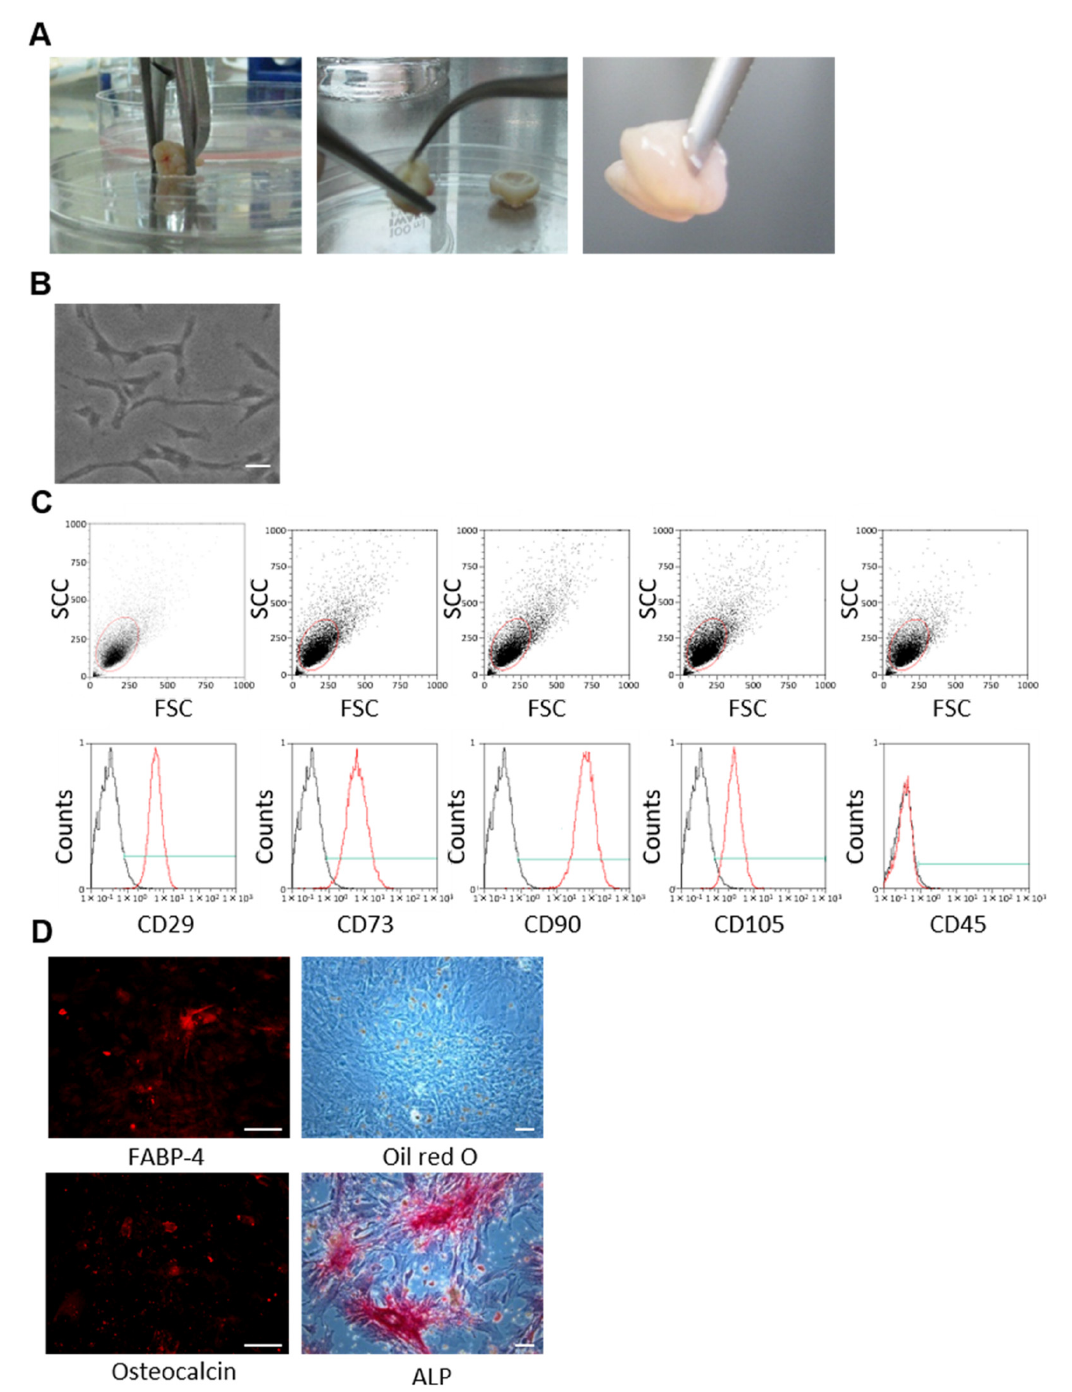
Figure 1. Identification of hDPSCs. ( A ) The dental pulp tissue was collected from third molars with forceps. ( B ) Observation of cultured hDPSCs with a phase-contrast microscope. Scale bar = 100 µm. ( C ) Surface marker expression, as analyzed by flow cytometry. Red circles: gated cells. Red lines: stained with specific antibodies. Black lines: isotype controls. Green lines: positive areas. Cell number: 1 × 10 5 /mL. ( D ) Adipogenic differentiation detected by FABP-4 and Oil Red O staining. Osteogenic differentiation was detected by osteocalcin and ALP staining. Scale bar = 100 µm.